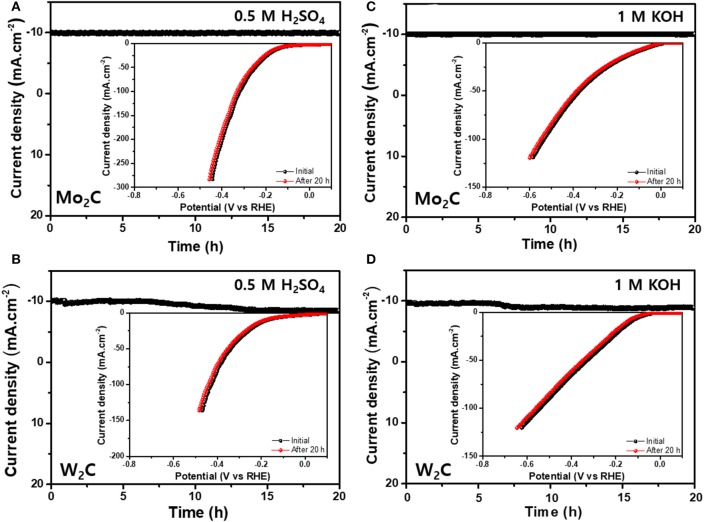
Long-term stability tests (A,B) chronoamperometric curves for Mo2C- and W2C-loaded NF electrocatalyst in 0.5 M H2SO4 (inset: corresponding LSV profiles for initial and after 20 h of HER performance) and (C,D) Chronoamperometric curves for Mo2C- and W2C-loaded NF electrocatalyst in 1.0 M KOH (inset: corresponding LSV profiles for initial and after 20 h of HER performance).